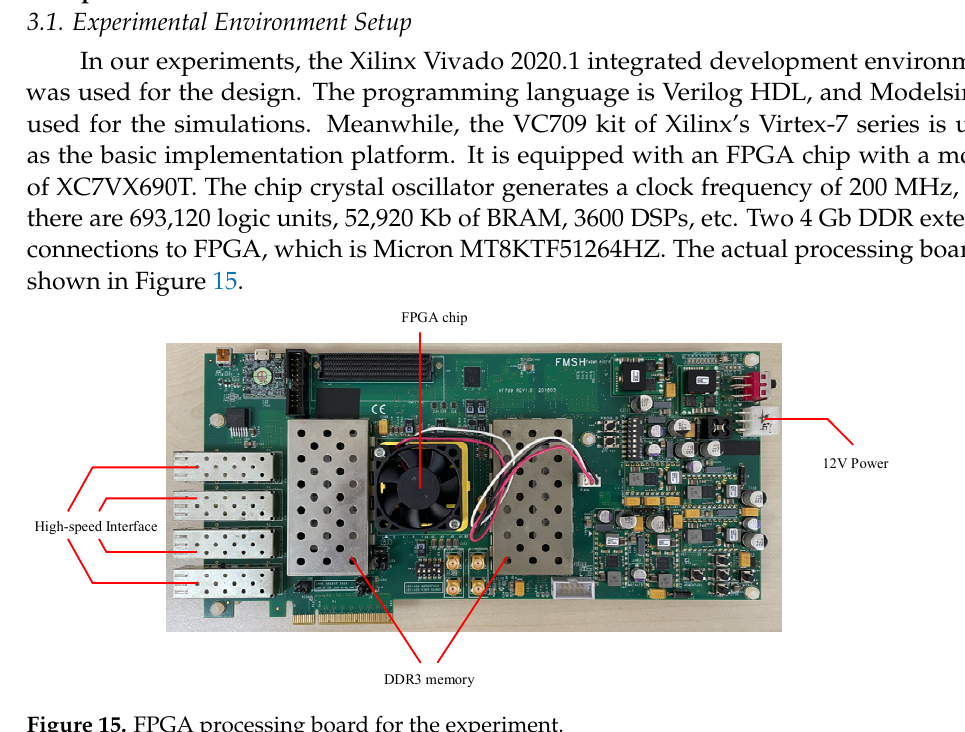
Figure 14. The schematic diagram of the residual calculation module.